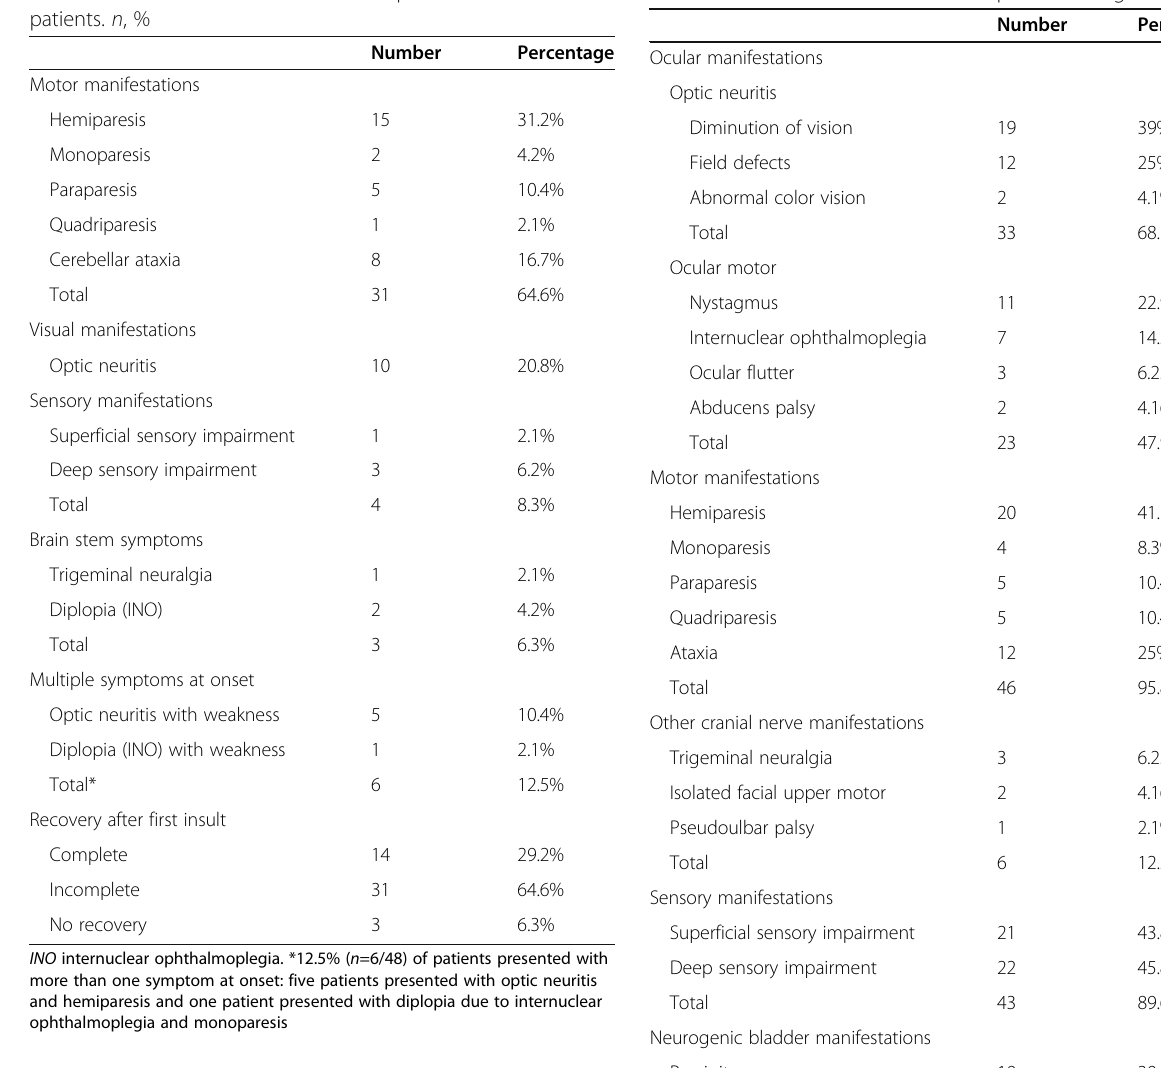
Table 2 Clinical manifestations of MS patients along MS